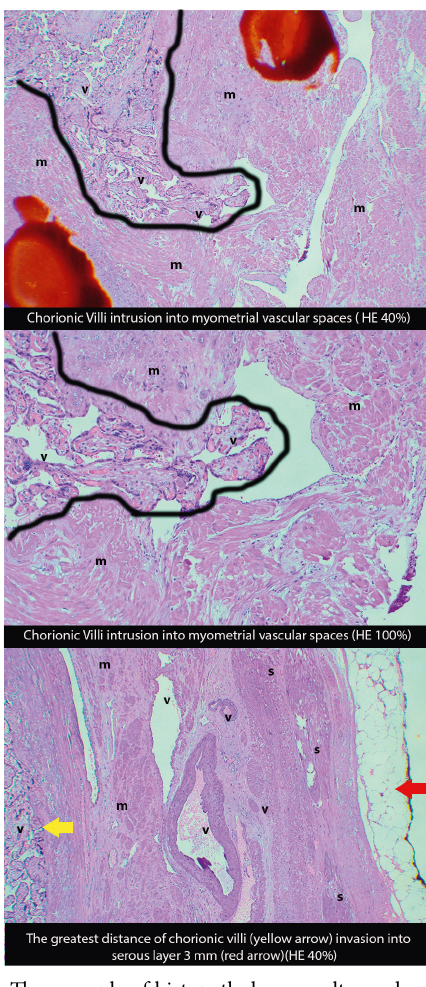
Figure 2: The example of histopathology results. v, chorionic villi; m, myometrium; s, serous layer; black lines, trophoblastic invasion lines. Table 4: Correlation of vascular indexes with the level of blood loss. Variables